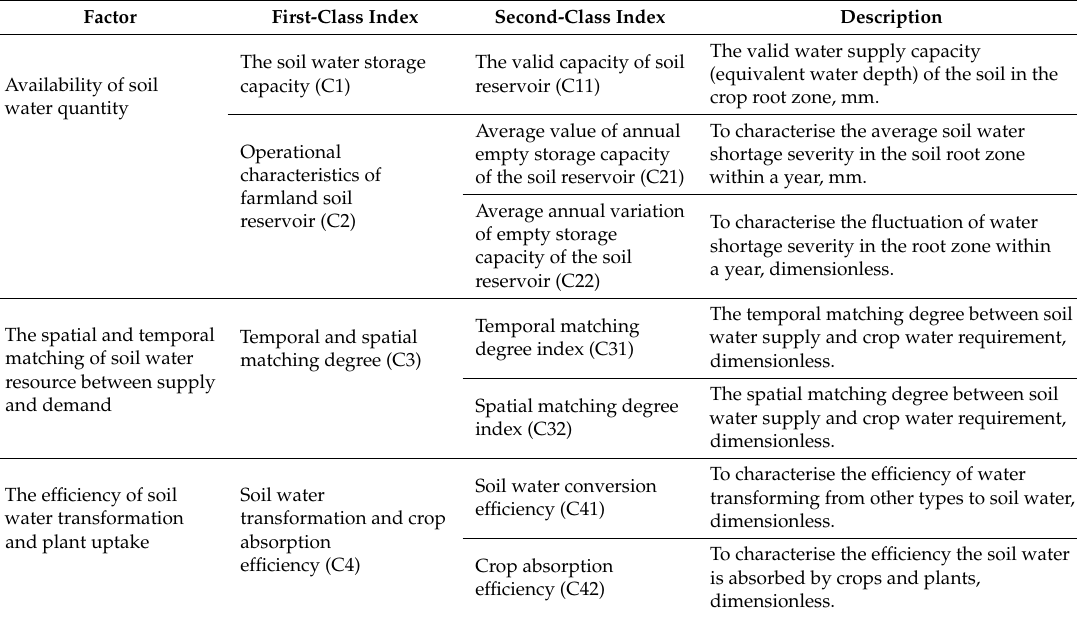
Table 1. Evaluation index system for farmland soil water